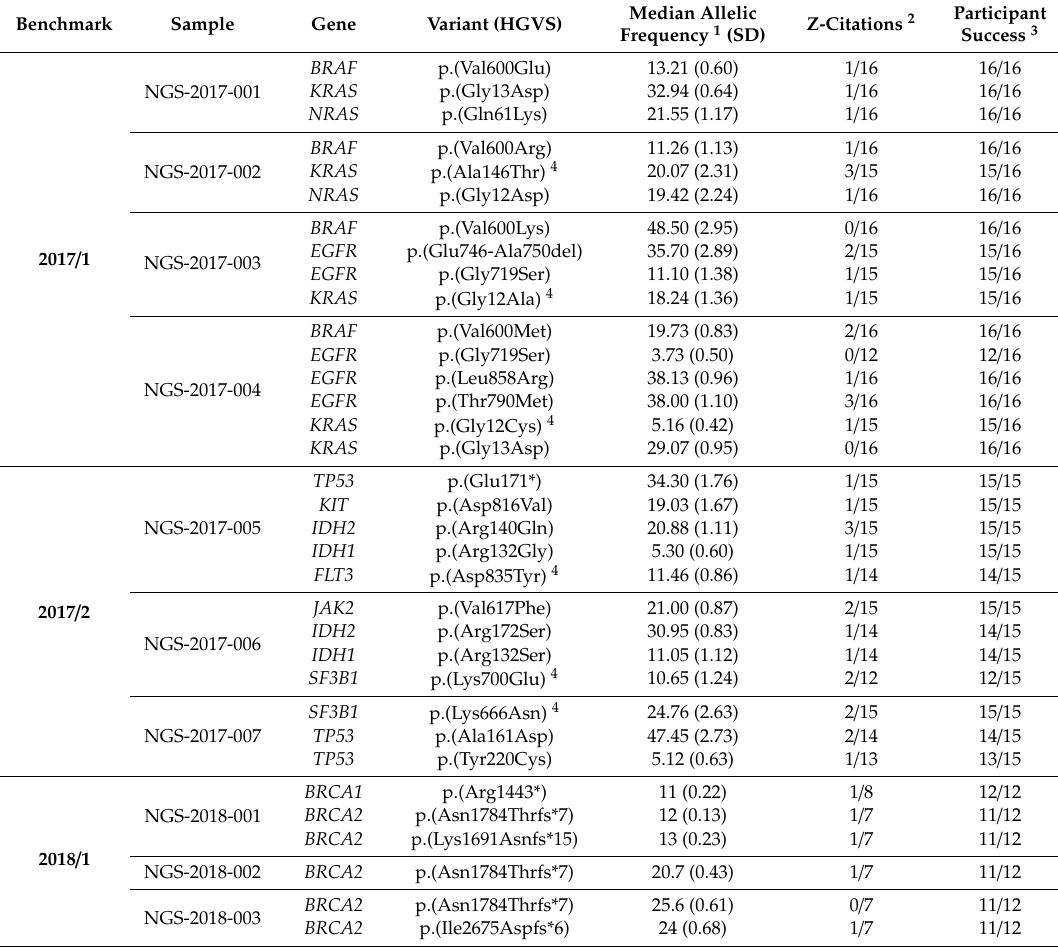
Table 3. Participant results for evaluative variants per benchmark.